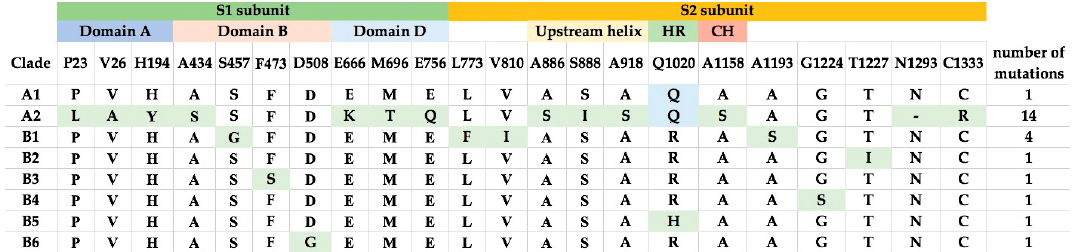
Figure 4. Amino acid substitutions in S proteins from the different clades of MERS-CoV. The S1 and S2 subunits, and structural domains are highlighted. The amino acid substitutions are highlighted and the total number of mutations in each clade are shown in the last column.